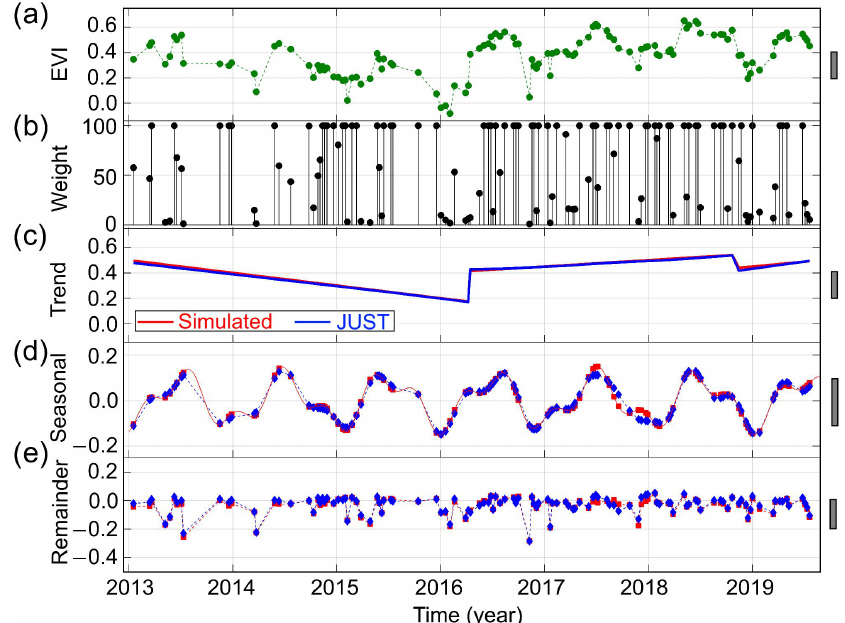
Figure 10. Decomposition of a noisy unequally spaced EVI time series into trend, seasonal, and remainder components. ( a ) the simulated EVI time series, ( b ) the weights associated with the time series values derived from the η 2 noise, and ( c – e ) the estimated and simulated results for trend, seasonal, and remainder components, shown in blue and red, respectively. The solid bars with the same data range are displayed on the right-hand side of the plot to help